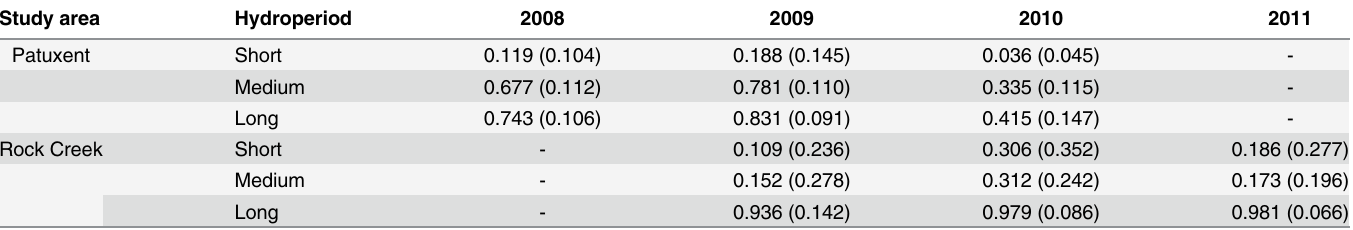
Table 3. Means (SD) of posterior predictive distributions of the probability of vernal pools supporting wood frog metamorphosis ( c ^ 2 ) at Patuxent National Research Refuge, Maryland, USA and Rock Creek National Park, Washington, DC, USA. Study